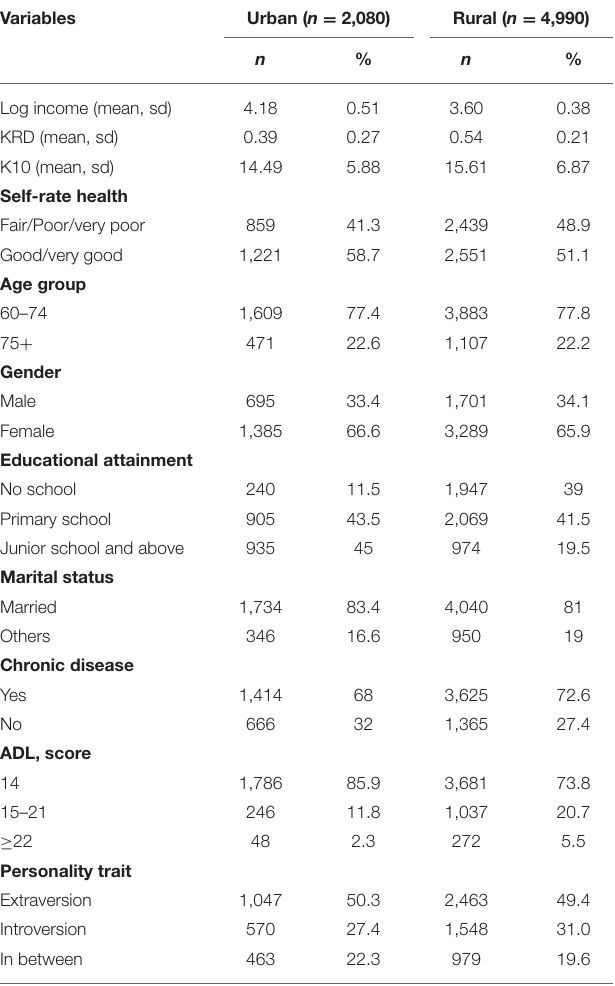
TABLE 1 | General characteristics of the older people according to residence.